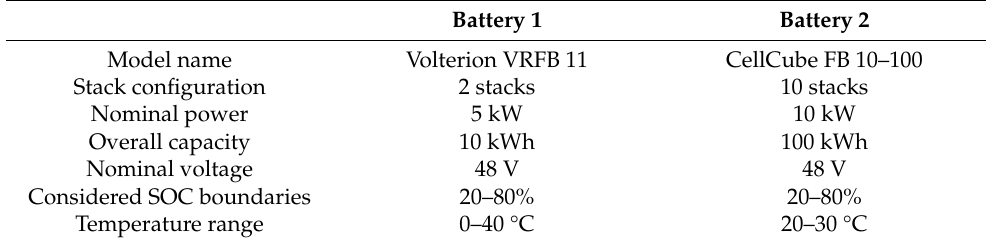
Table 1. Overview: Comparison of the preset parameters of the simulation